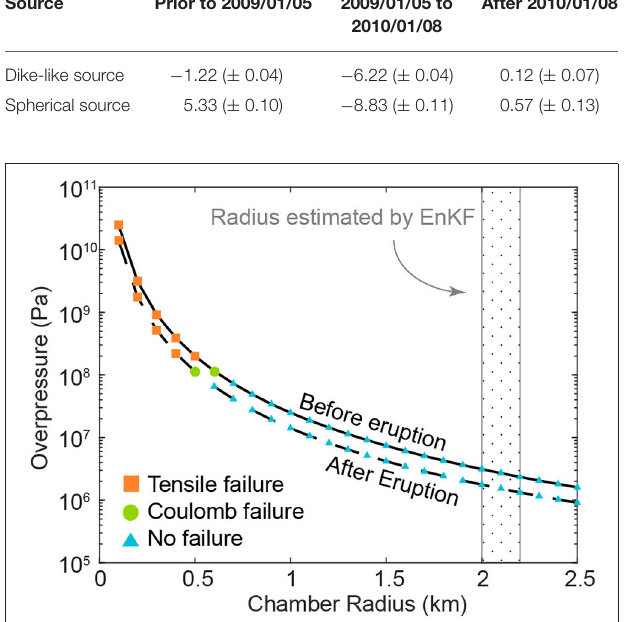
FIGURE 7 | The relationship between the assumed overpressure of the chamber and its corresponding radius before (solid line) and after (dashed line) the 2009 eruption of Kerinci Volcano. The overpressure and the radius cannot be uniquely determined due to the nature of the deformation source. Colored symbols indicate that the type of the failure predicted at the top of the magma chamber is controlled by the combination of the overpressure and the radius. Blue triangles indicate a stress state where no failure is calculated. Green circles indicate a situation where only Coulomb failure is predicted. The orange squares indicate a stress state in which tensile failure is predicted. Figure 8 provides an illustration of this